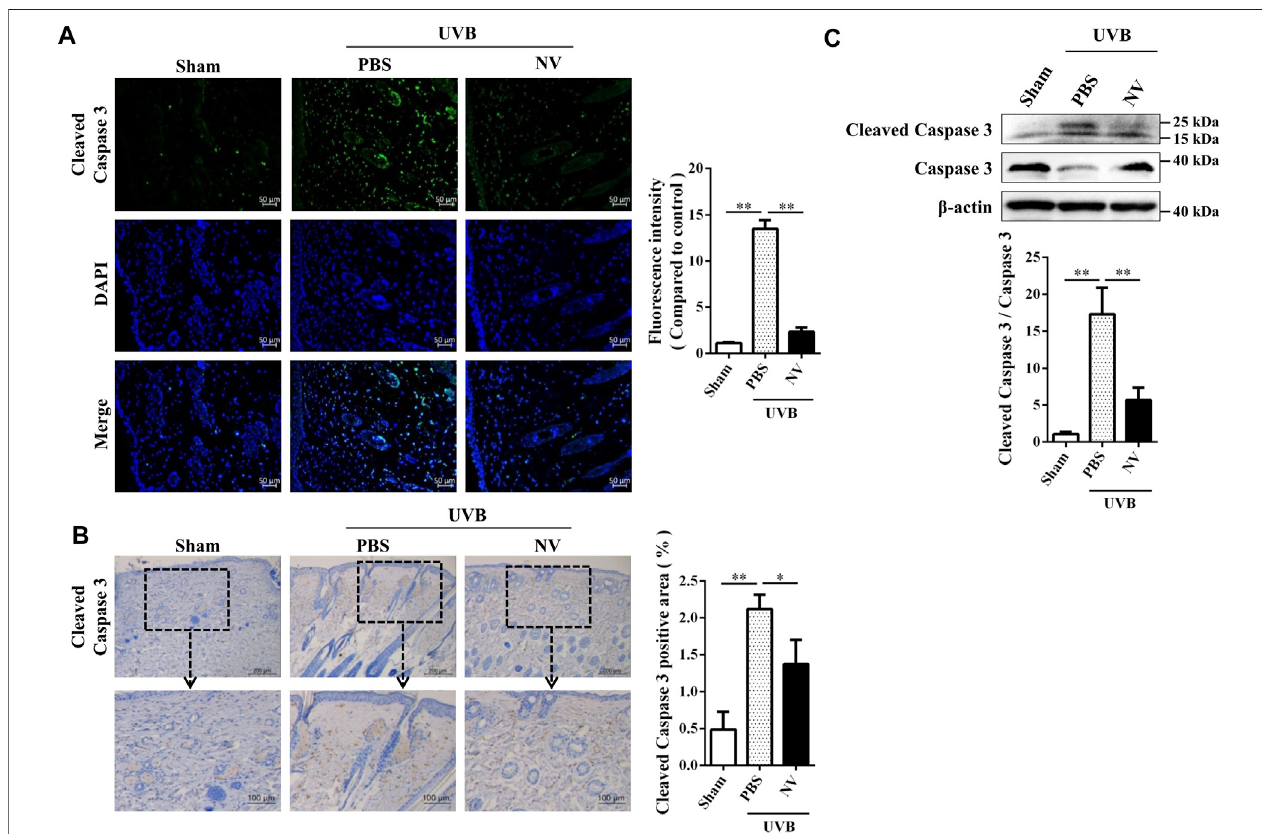
FIGURE 6 | Antioxidin-NV inhibited UVB-induced apoptosis in the skin of hairless mice. (A) skin tissues were taken and paraf fi n blocks were cut into 4 μ m thick sections for anti-Cleaved Caspase3immuno fl uorescence.Cleaved Caspase3proteinsarestainedgreen.Scale bar (cid:1) 50 μ m. (B) Immunohistochemicalstainingofskin tissueswasusedtodeterminetheexpressionlevelsofCleavedCaspase3.CleavedCaspase3proteinsarestainedbrown(Indicatedbyredarrow).Scalebar (cid:1) 200 μ m. (C) Westernblotwasperformedtoanalyzetheexpressionofanti-Caspase3andanti-CleavedCaspase3proteinsandrelativeactivationanalysiswasquanti fi edby Image J. Data are presented as mean ± SD ( n (cid:1) 3). * p < 0.05, ** p <